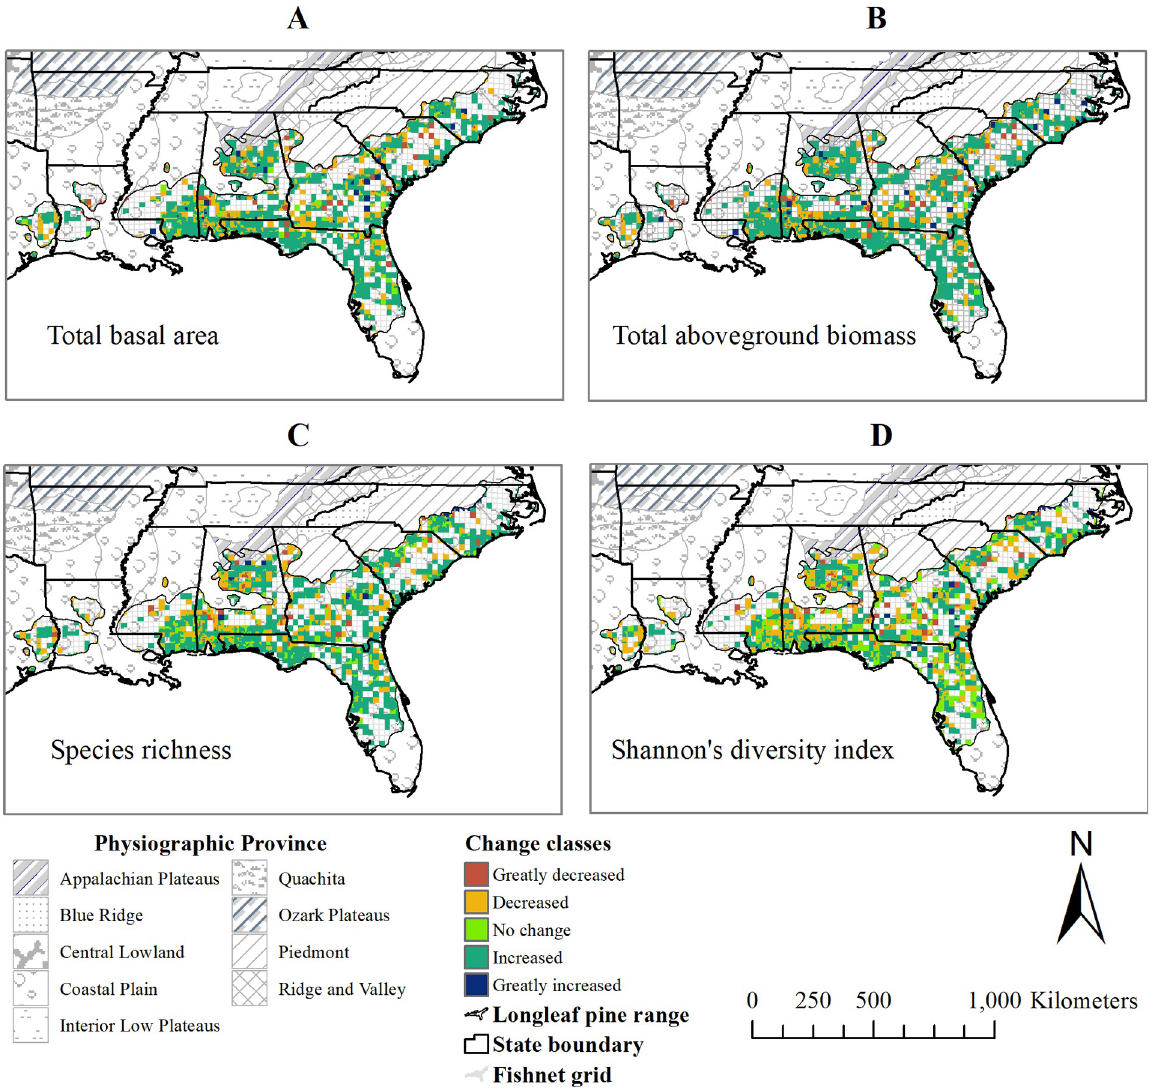
Fig 6. Change detection maps showing the spatial distribution of change in (A) total basal area (m 2 ha -1 ), (B) total aboveground biomass (Mg ha -1 ), (C) species richness, and (D) Shannon’s diversity index, in the study area between 2004 and 2011. Where 2004 and 2011 are the centroid- year of first (1997–2010) and last (2003–2018) inventory intervals, respectively. (Shapefile data sources: US state boundary [25], Physiographic Province [21], and Longleaf pine range